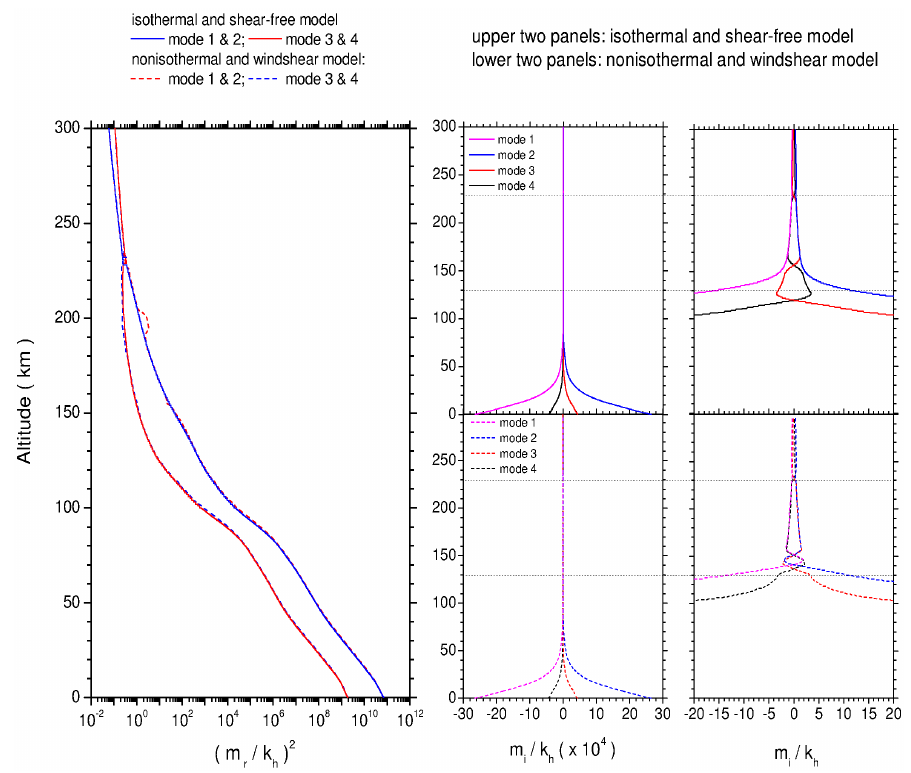
Figure 8. Effect of isothermality and wind shear on four extraordinary dissipation wave modes from the Z 6 -dispersion equation, Equation (18), applicable for the region below a 230-km